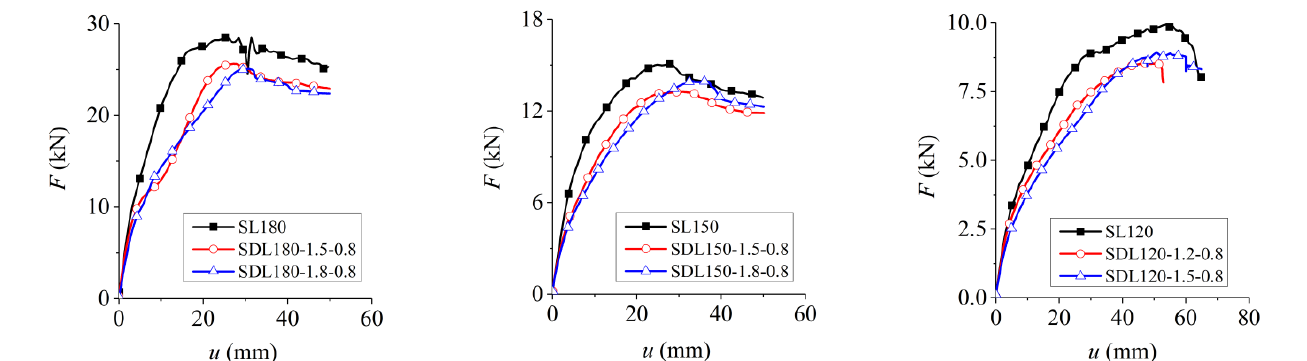
Figure 7. Load–displacement curves of residual capacity Figure 7. Load ‒ displacement curves of residual capacity tests.